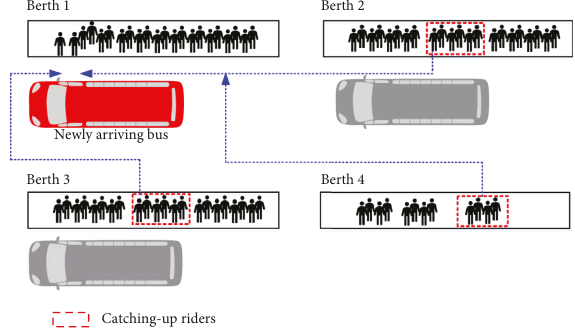
Figure 1: Rider transfer among berths for the newly arriving bus at Berth